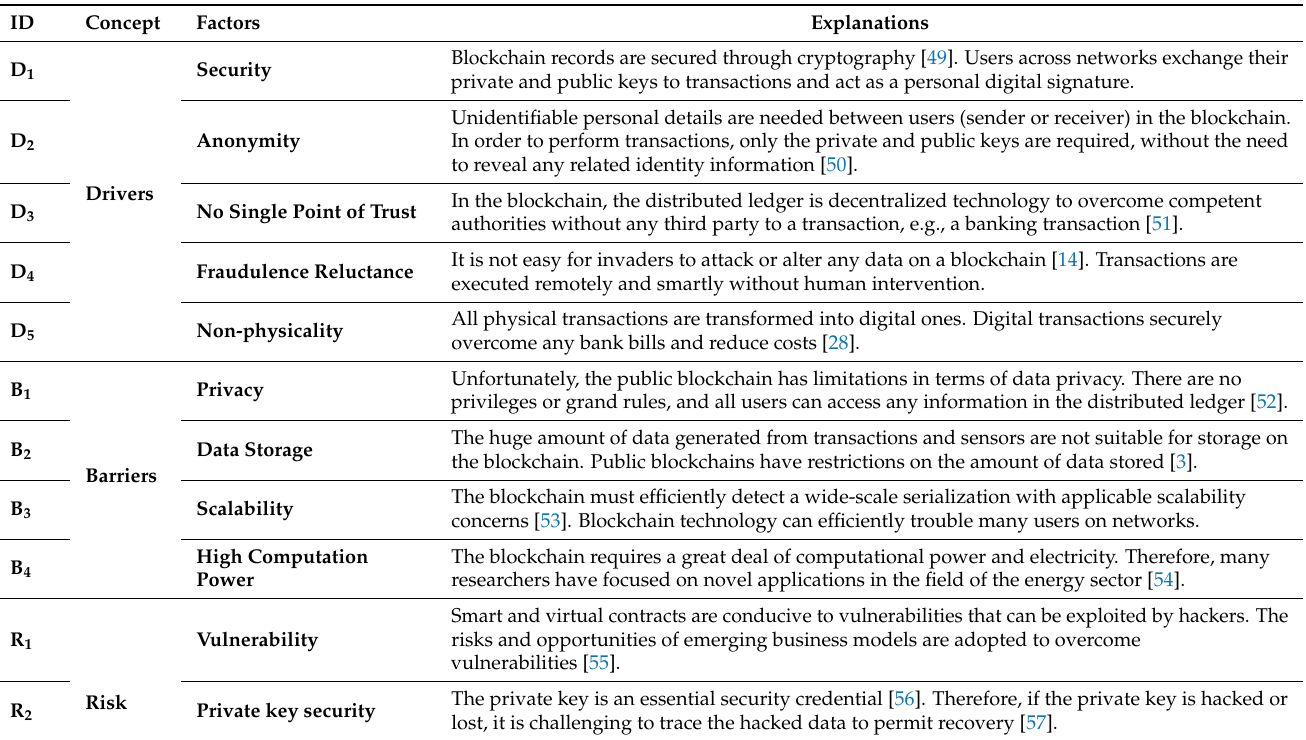
Table 2. A detailed explanation of the main drivers, barriers, and risks affecting the manufacturing of